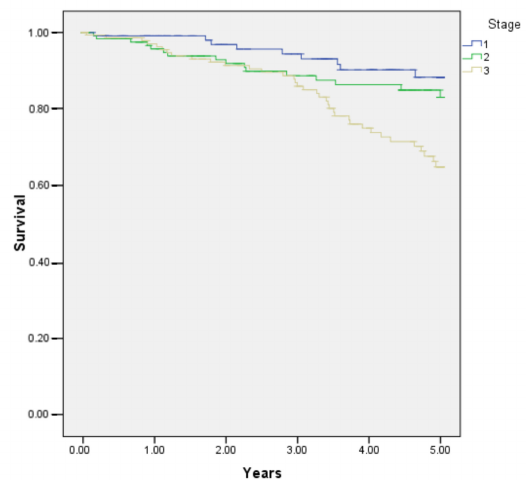
Figure 3. 1-year survival according to TNM stage of patients undergoing hand-assisted laparoscopic surgery for cancer (stage I–III).